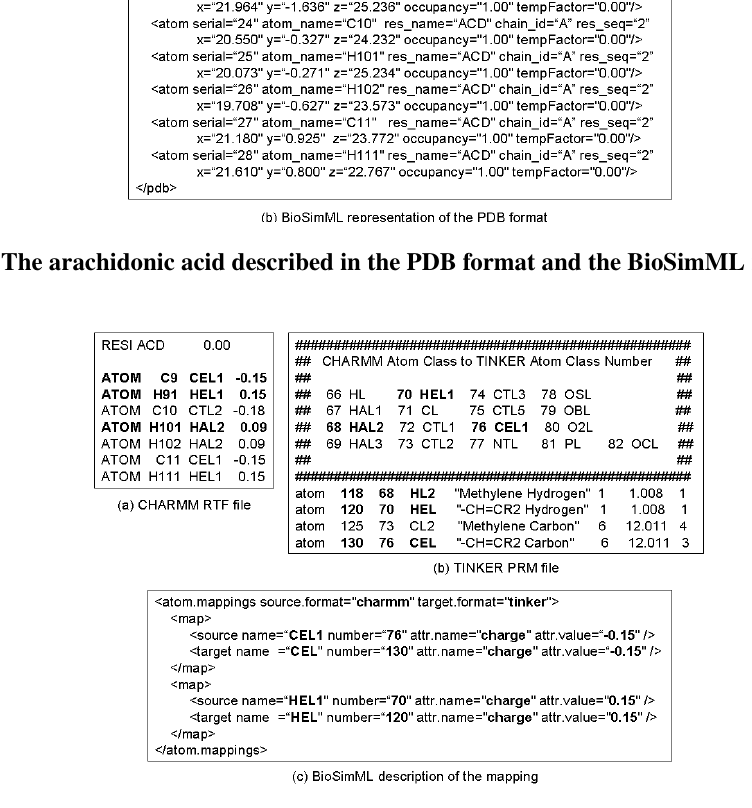
Figure 4: The mapping of atom names and types between the CHARMM and TINKER